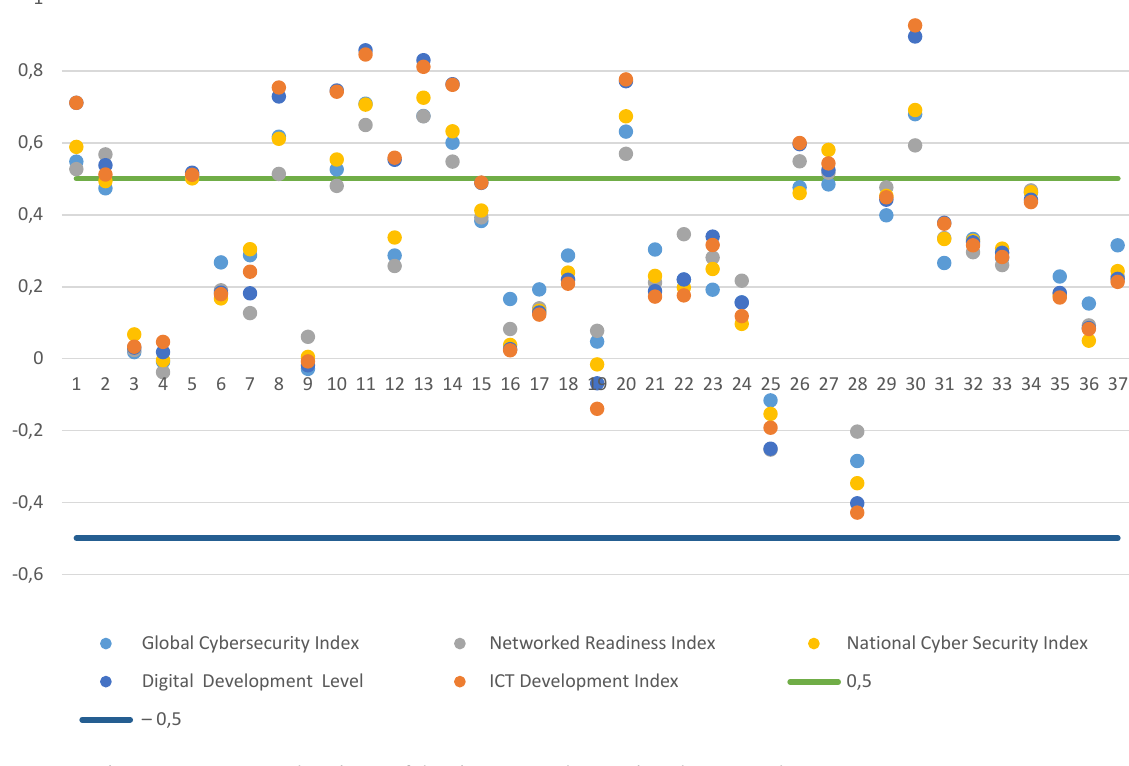
Figure 2. Results of correlation